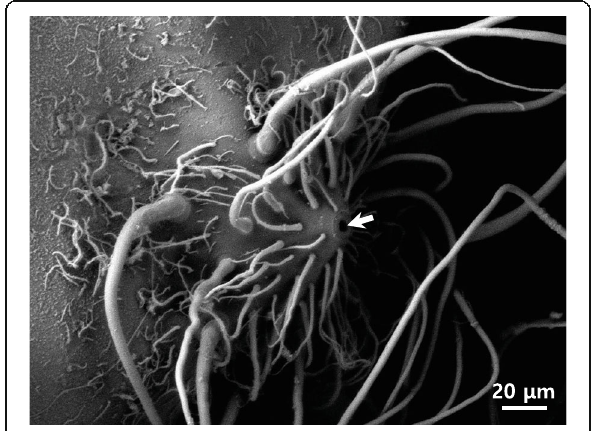
Fig. 4 The outer surface of fertilized egg envelope. The outer surface was rough and there were no adhesive filaments on other side of egg envelope excepting micropylar